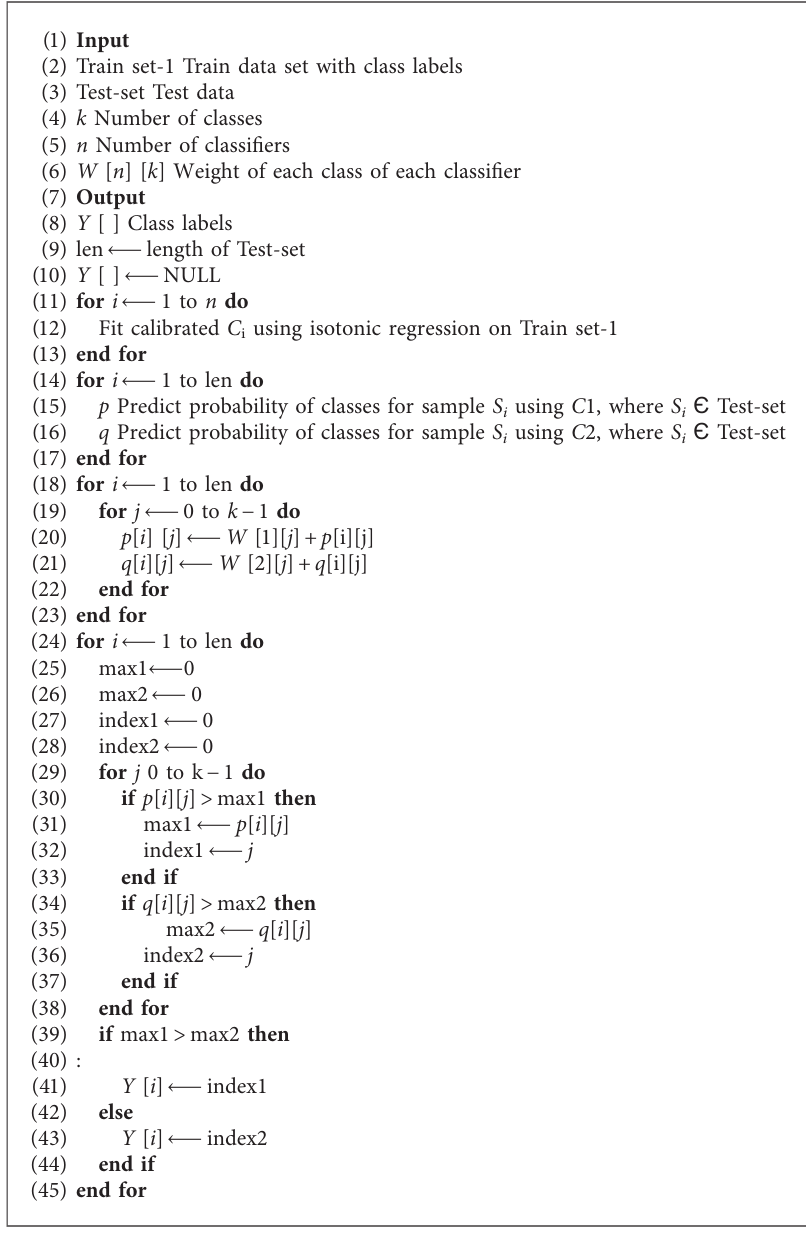
A LGORITHM 3: Algorithm for the selection of final class for